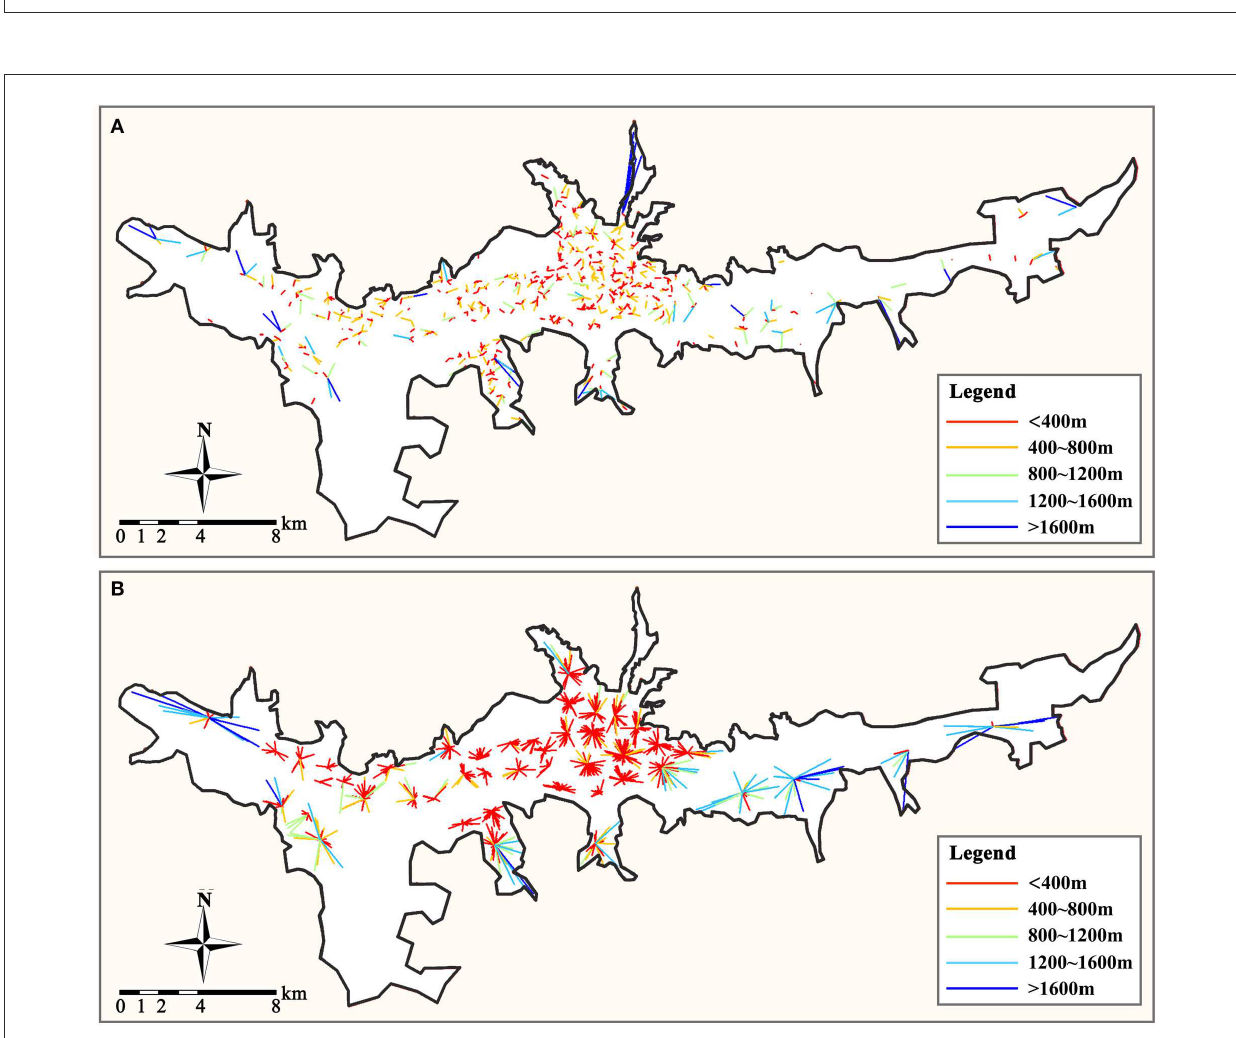
FIGURE10 Optimized spatial distribution of Origin-Destination links. (A) From residences to community clinic. (B) From residences to health